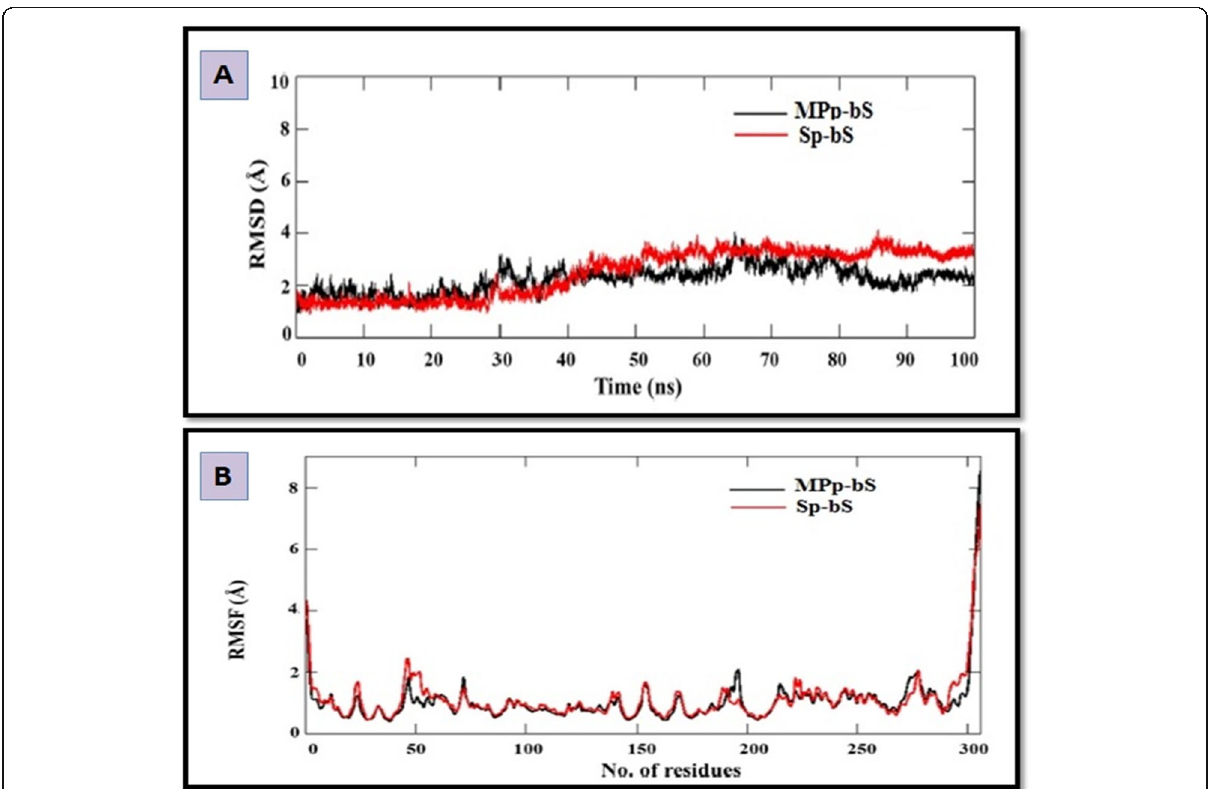
Fig. 5 Trajectory analysis for docked complexes. a RMSD plot (1 to 3 Å). b RMSF plot (1 to 8